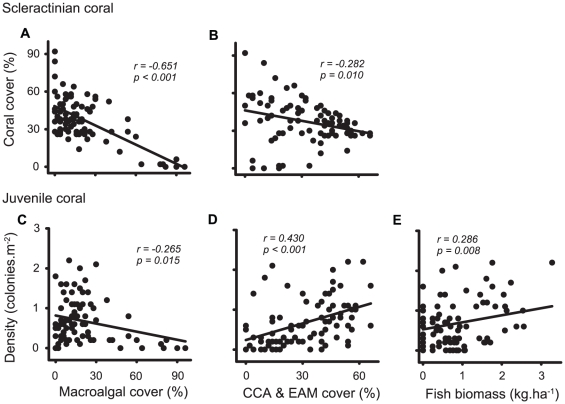
Relationships among major benthic categories and the biomass of grazing fishes on Lord Howe Island.Correlations between the cover of live coral and (A) the cover of macroalgae, and (B) the cover of EAM and CCA. Correlations between the density of juvenile corals and (C) the cover of macroalgae, (D) the cover of EAM and CCA, and (E) the biomass of grazing fishes. Each point represents values from individual transects (n = 84). The best-fit relationships (linear) are given as solid lines, along with r and p values.